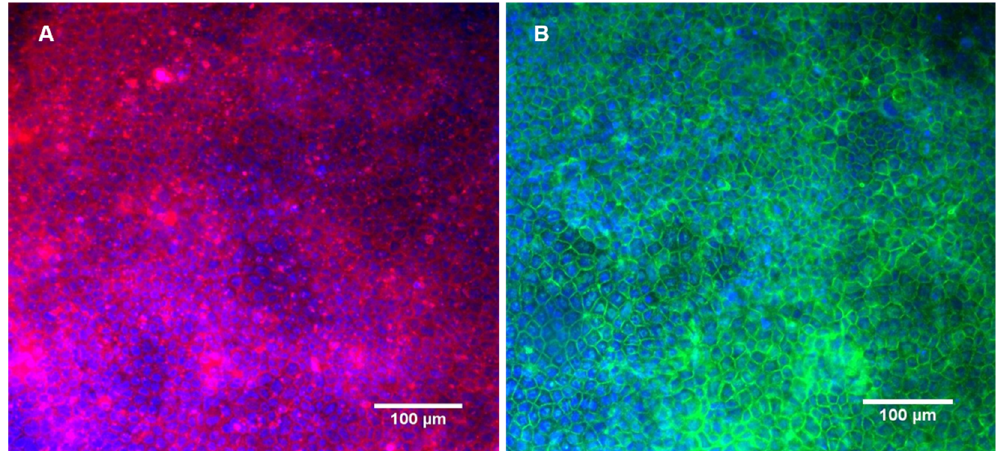
Figure 6. Caco-2 monolayer cultured in the bioreactor after the incubation with curcumin and subsequent P-gp activity assay. Fluorescence staining of the nuclei, actin microfilaments ( A ) and occludin ( B ).